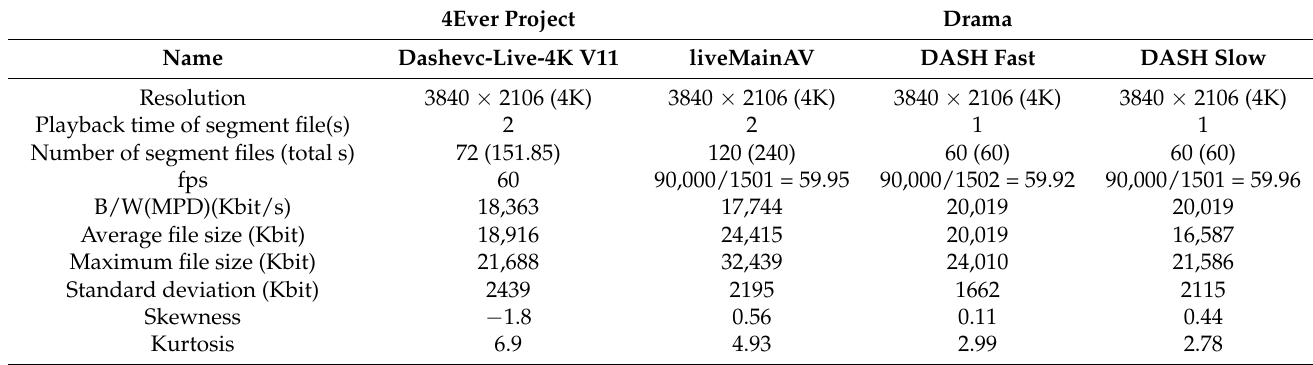
Table 3. DASH dataset (high efficiency video